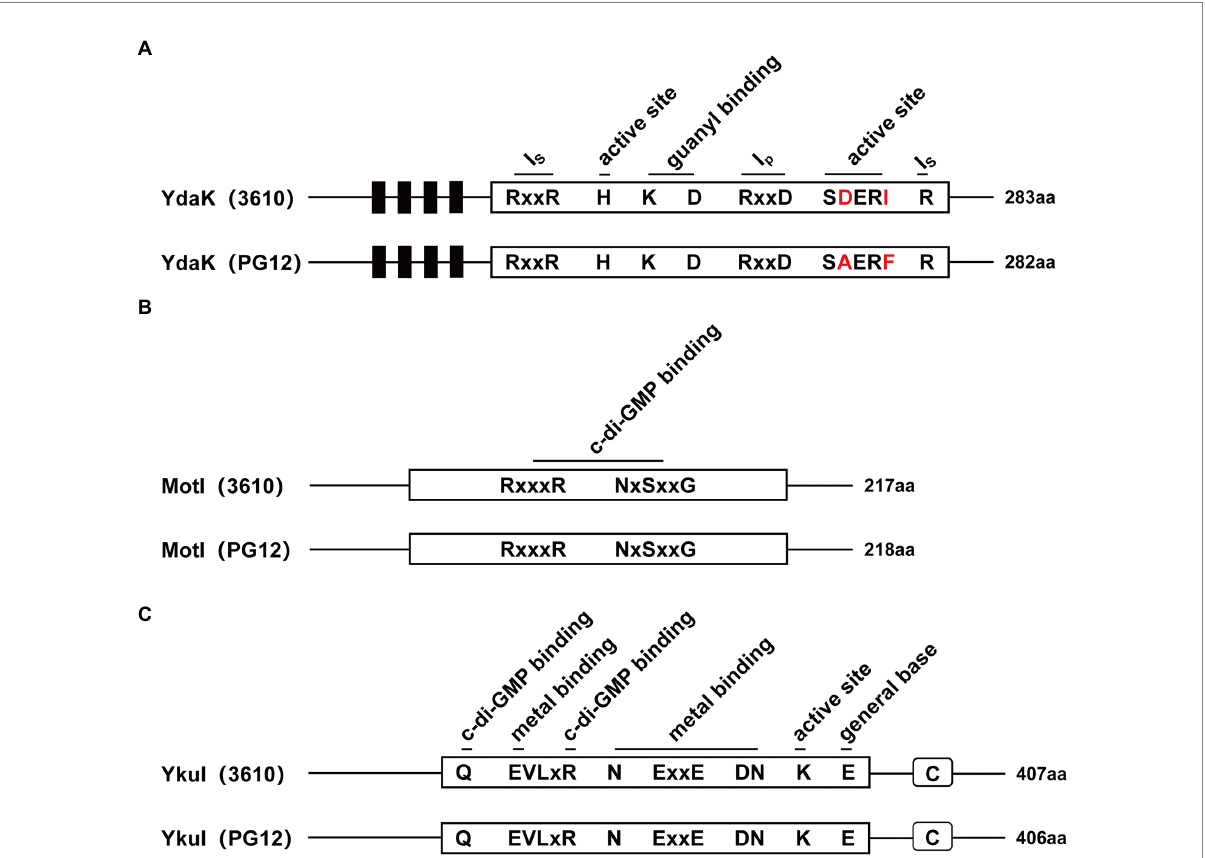
FIGURE 6 Domain architectures of Ydak, MotI, and YkuI in B. velezensis PG12 and B. subtilis 3,610. The number of amino acids in each protein is shown. (A) The domain architecture of the degenerated GGDEF domain of YdaK. Ip is the primary inhibitory binding site for c-di-GMP and is the secondary inhibitory binding site for c-di-GMP. Active site means the degenerated GGDEF. Predicted transmembrane regions are shown as black bars. (B) The domain architecture of the PilZ domain protein MotI with highly conserved c-di-GMP binding site. (C) The domain architecture of the degenerated EAL domain of YkuI. Highly conserved sites of the degenerated EAL residues are outlined in black. C stands for C-terminal domain from YkuI of unknown